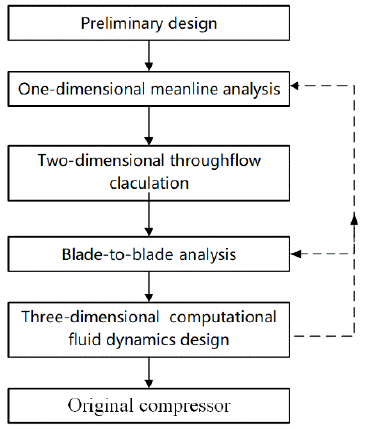
Figure 2. Simplified schematic diagram of the design process of the highly loaded compressor.